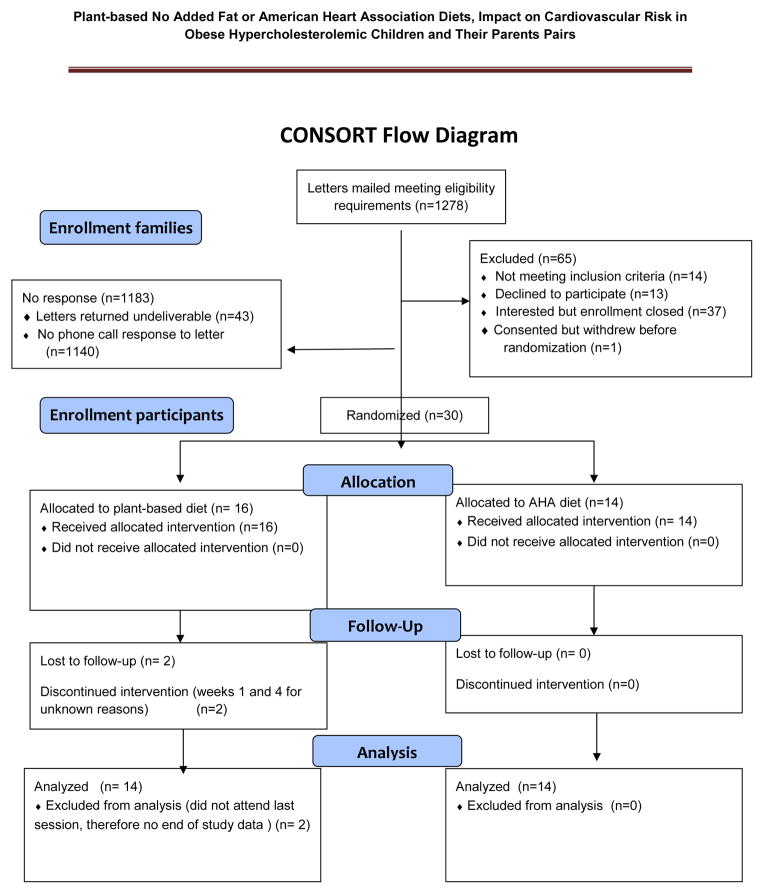
Consort Diagram